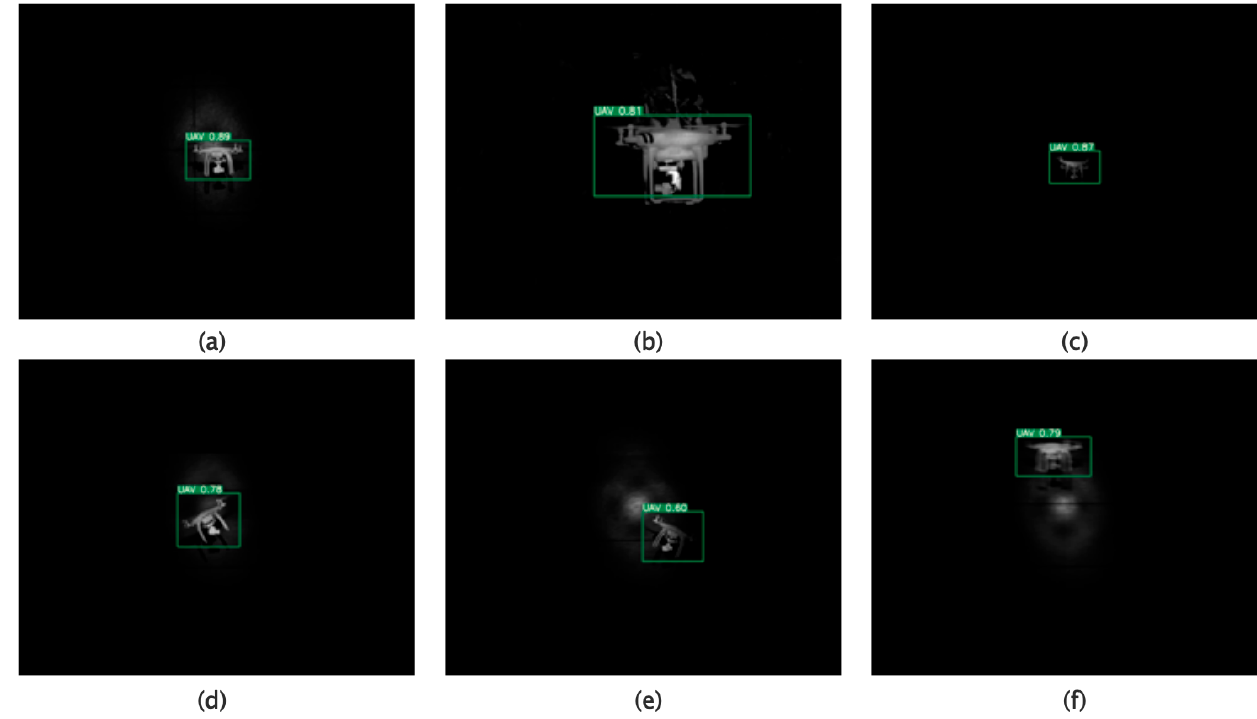
Figure 8. Detection results of our approach on real laser active imaging data. The top row presents the detection results of UAVs hovering in different backgrounds, from left to right are buildings ( a ), trees ( b ), and the sky ( c ). The bottom row (including d – f ) shows the detection results when the UAV is at different flight attitudes with buildings in the background.